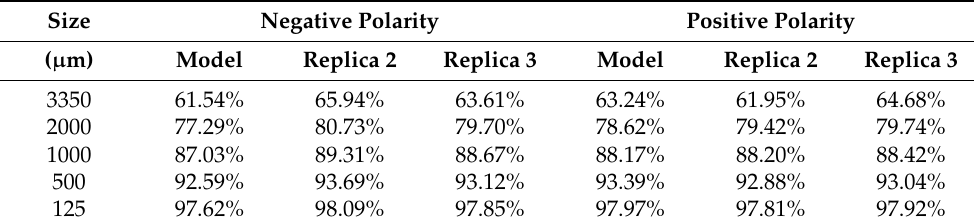
Table 5. PSD values (modeled and real), feed 5000/3350 µ m monosize, five pulses.